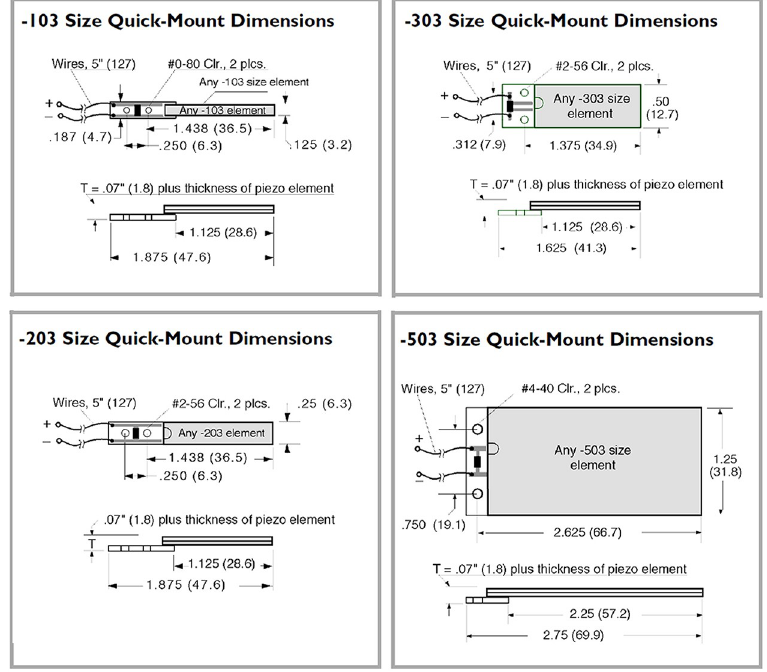
Fig 2. The variety of some of the piezoelectric transducer in custom configurations and sizes designs [22] [23].